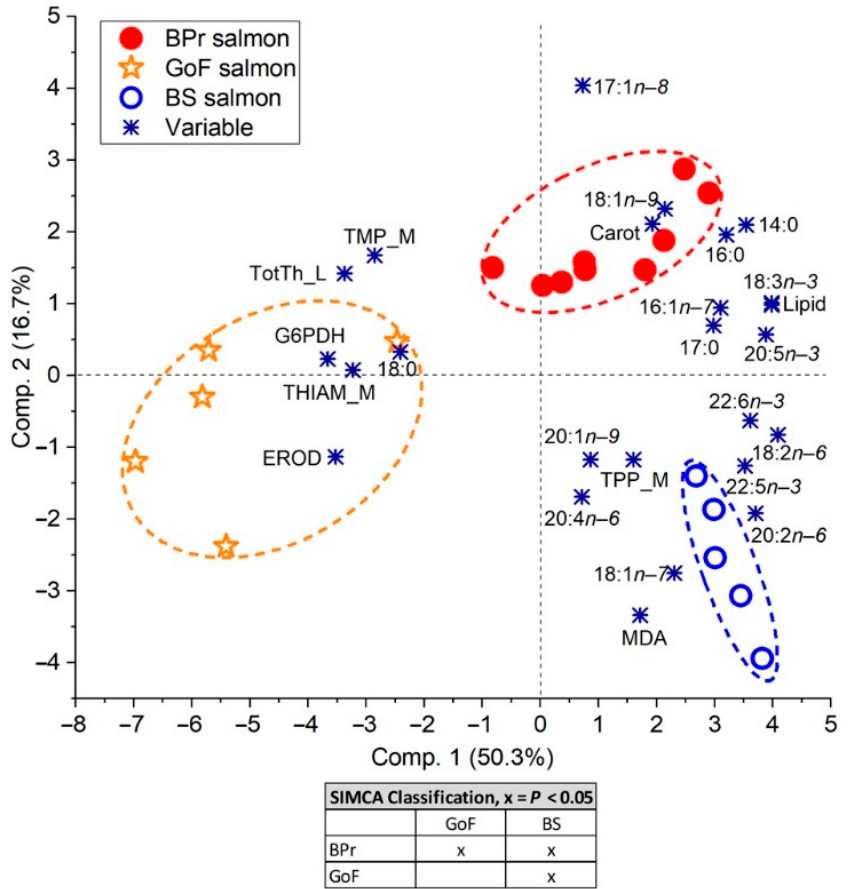
Figure 9. Biplot from the PCA model with principal components 1 and 2 for salmon ( Salmo salar ) caught in the Baltic Proper (BPr), the Bothnian Sea (BS), and the Gulf of Finland (GoF) in the late fall, and the variables measured: the activity of glucose 6-phosphate dehydrogenase (G6PDH) and 7-ethoxyresorufin- O -deethylase (EROD) and the concentration of malondialdehyde (MDA) and total thiamine in liver (TotTh_L), the concentrations of thiamine components (TPP = thiamine pyrophosphate, TMP = thiamine monophosphate and THIAM = unphosphorylated or free thiamine) in the muscle (M), the concentration of total carotenoids (Carot) and the concentrations of individual fatty acids, and the lipid content (Lipid) in the whole body. Results of the paired SIMCA test for salmon from the three Baltic Sea areas are also presented.